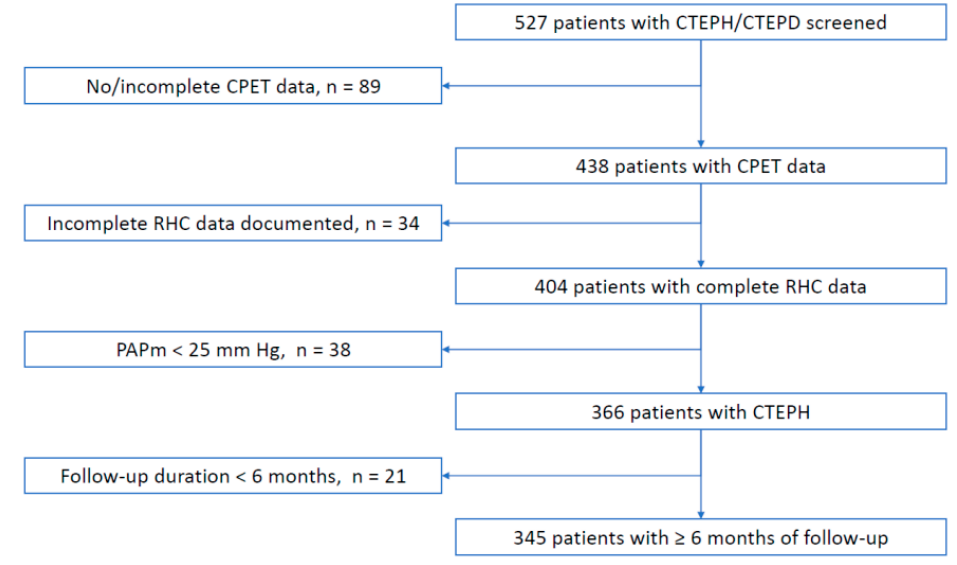
Figure 1. Study flow-chart.—Patient flow. CPET = cardiopulmonary exercise testing; CTEPD = chronic thromboembolic pulmonary disease; CTEPH = chronic thromboembolic pulmonary hypertension; PAPm = mean pulmonary artery pressure; RHC = right heart catheterization.